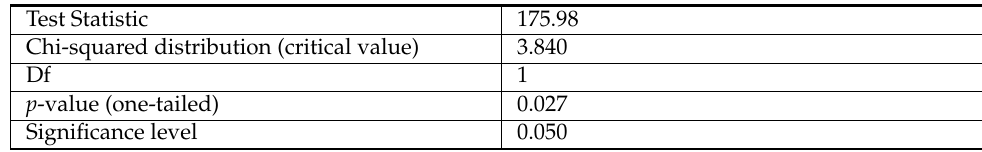
Table 3. Cochran’s Q test (asymptotic p